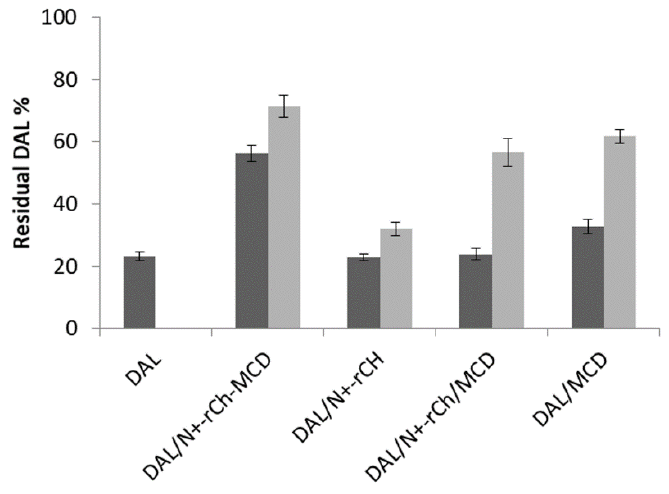
Figure 6. α-chymotrypsin (CHT) hydrolysis of DAL: Residual DAL % after 5 min of CHT activity on solutions ( ); on lyophilized complexes ( ). Error bars indicate the SD values of three independent experiments.